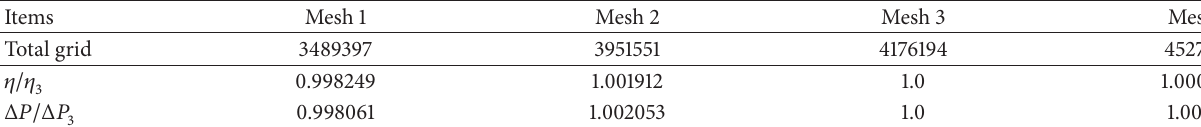
Figure 9: The meshing of helically coiled tube separator. Table 1: Evaluation of the dependency of mesh.